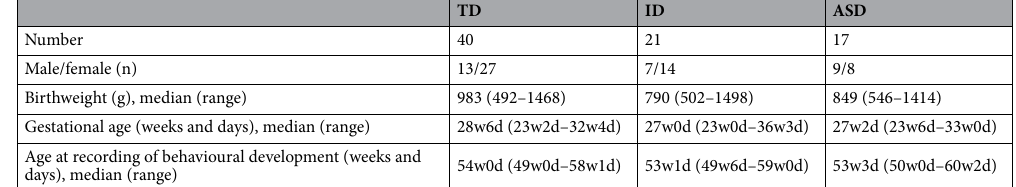
Table 2. Characteristics and developmental outcome of the early infancy assessment group. TD typical development, ID intellectual disability, ASD autism spectrum disorder. * p < 0.05 in comparison with TD group using the Mann–Whitney U